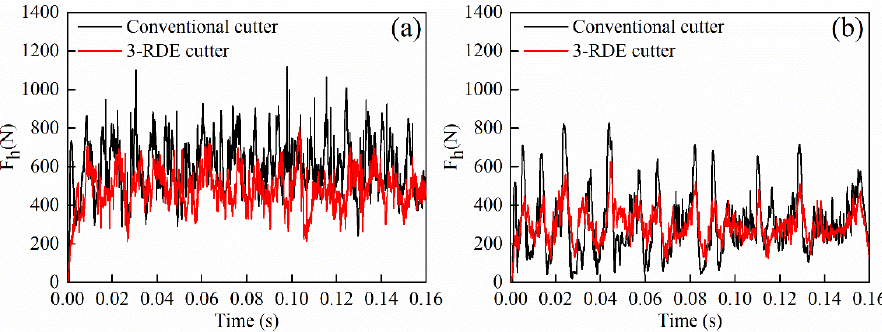
Figure 19. Response of tangential force in heterogeneous formations: ( a ) The sandstone formation with a high content of gravels; ( b ) The soft-hard staggered formation.